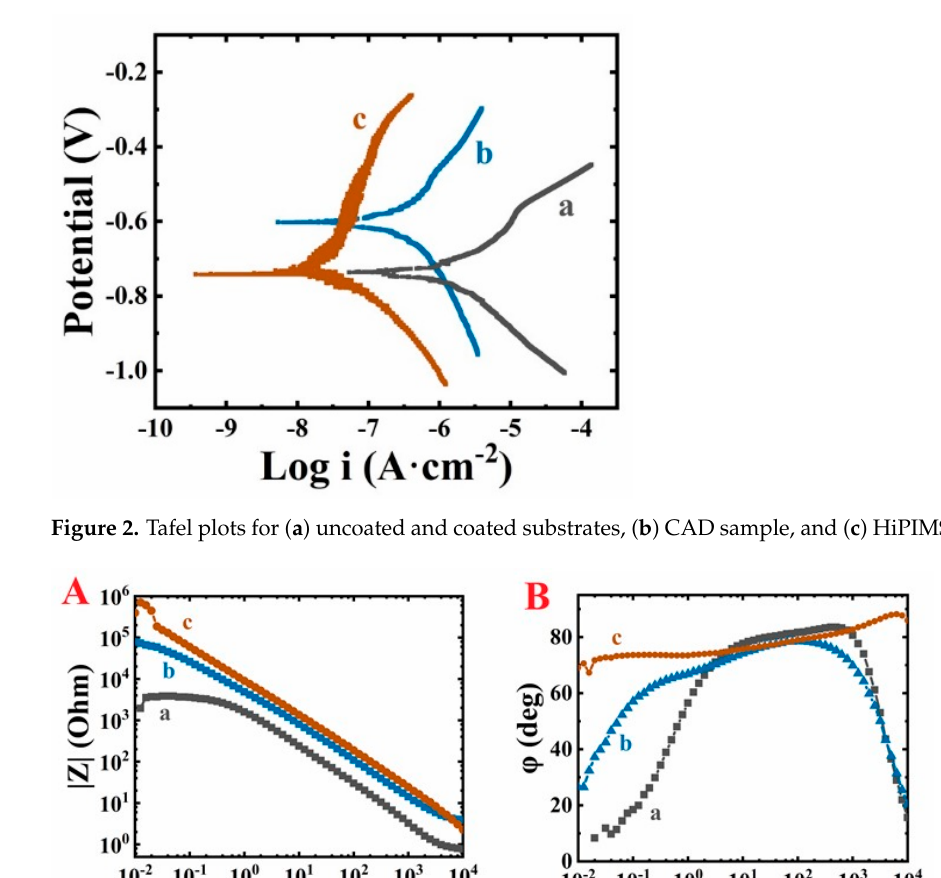
Figure 2. Tafel plots for ( a ) uncoated and coated substrates, ( b ) CAD sample, and ( c ) HiPIMS sam- ple.